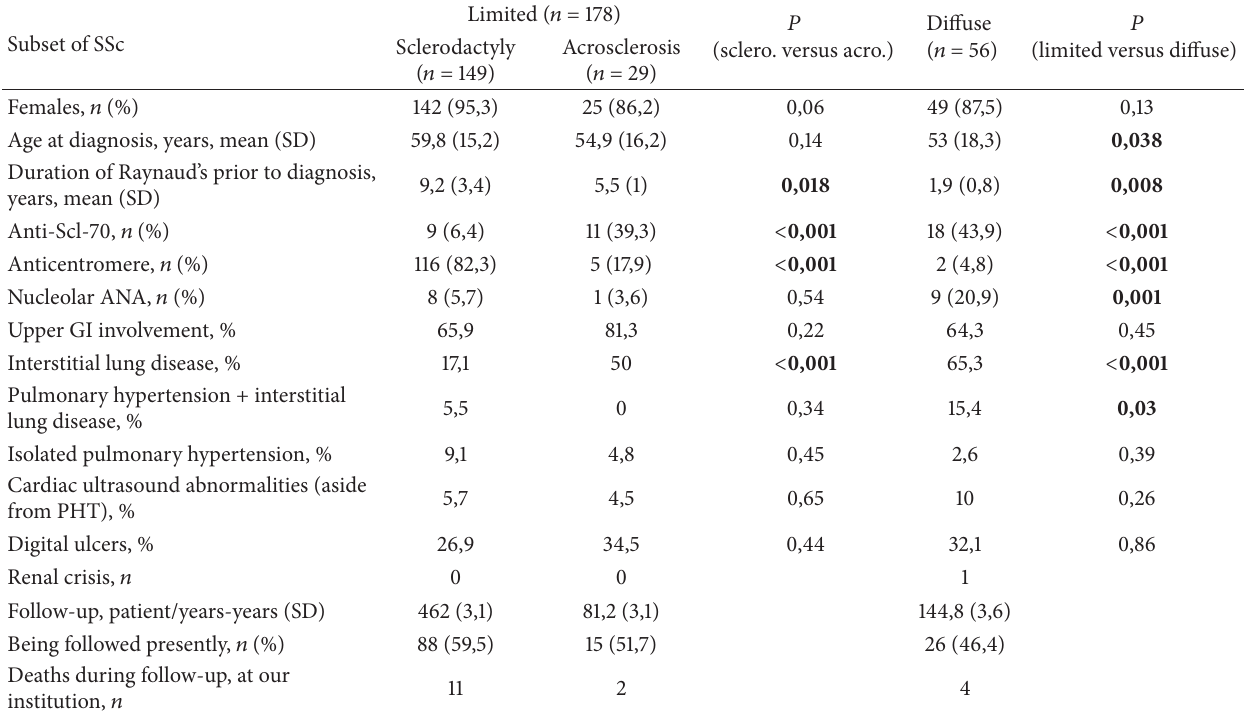
Table 1: Clinical and serological profiles of the 234 patients.